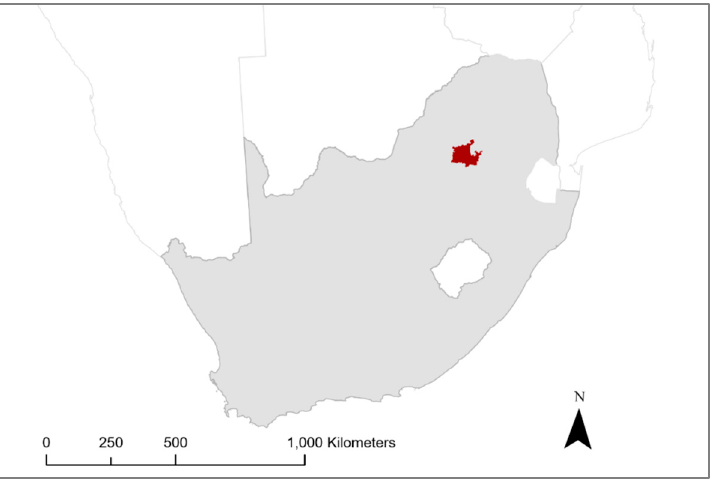
Figure 1. Location of the City of Tshwane metropolitan area in South Africa.